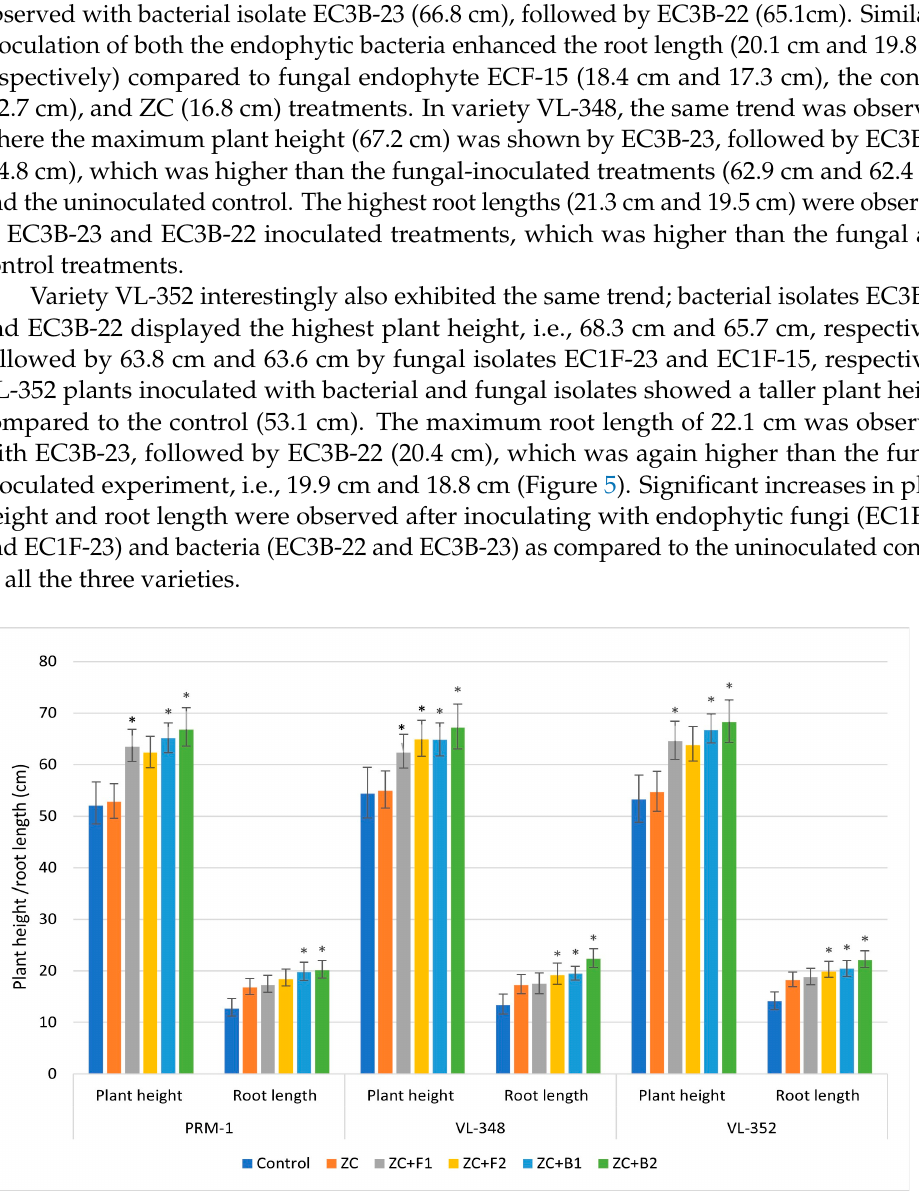
Figure 5. Endophyte inoculation in fl uencing plant height and root length (error bars indicate the mean value of triplicate experiments ± standard deviation). (ZC—zinc carbonate; F1—EC1F-15; F2—EC1F-23; B1—EC3B-22; B2—EC3B-23.) * Indicates signi fi cate values at 5% probability.